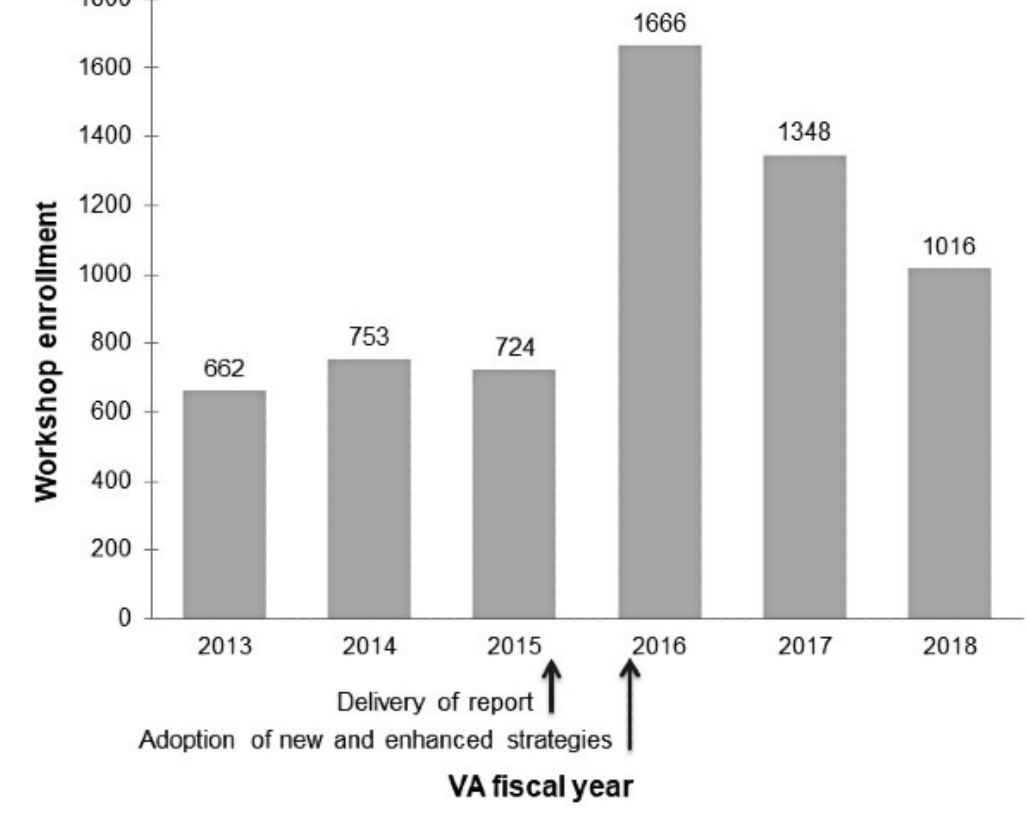
Figure 1. Workshop enrollment, 2013-2018. US Department of VA fiscal years encompass October through the end of September the following year. The study team reported integrated study findings and recommended new and enhanced strategies likely to improve workshop uptake to VA Building Better Caregivers national leaders in the late fiscal year 2015. In late 2015 and early 2016, the VA adopted a number of these recommended implementation strategies. VA: Veterans